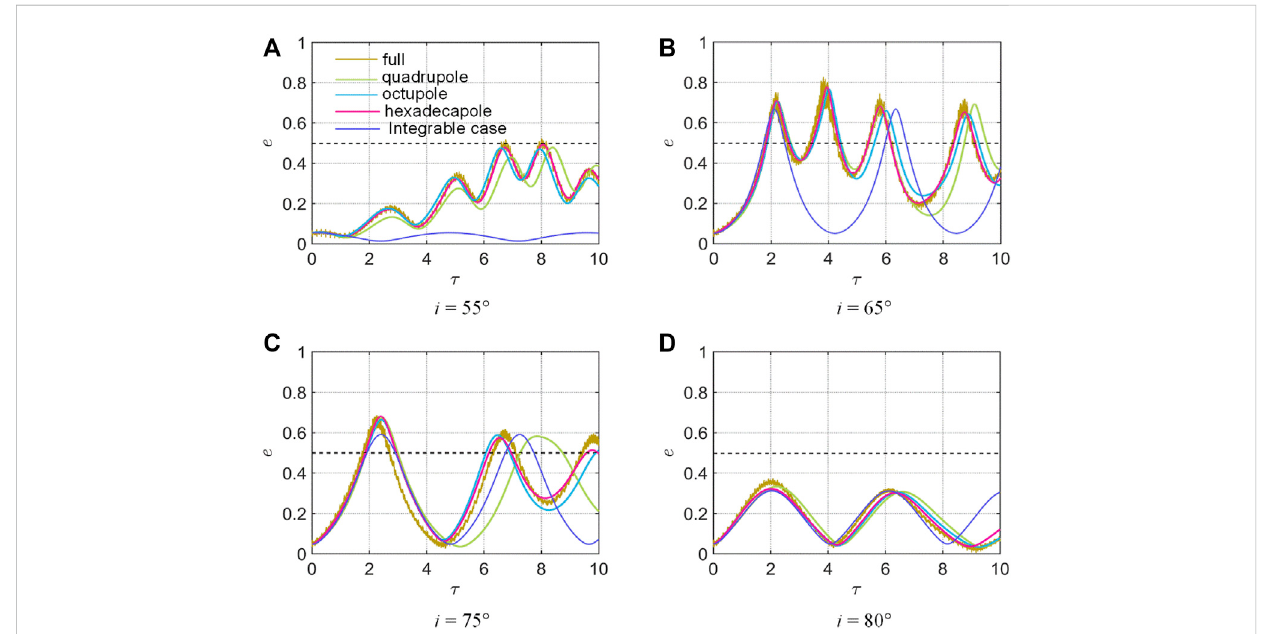
FIGURE 8 Long-term eccentricity evolution at different inclinations for a (cid:2) 5 . 5km with the other initial conditions set the same as Figure 4. The initial inclinations are set as 55 ° , 65 ° , 75 ° , and 80 ° in panels (A – D) , respectively. The integrable case corresponds to the quadrupole-level model with zero third- body inclination (remaining e B unchanged).